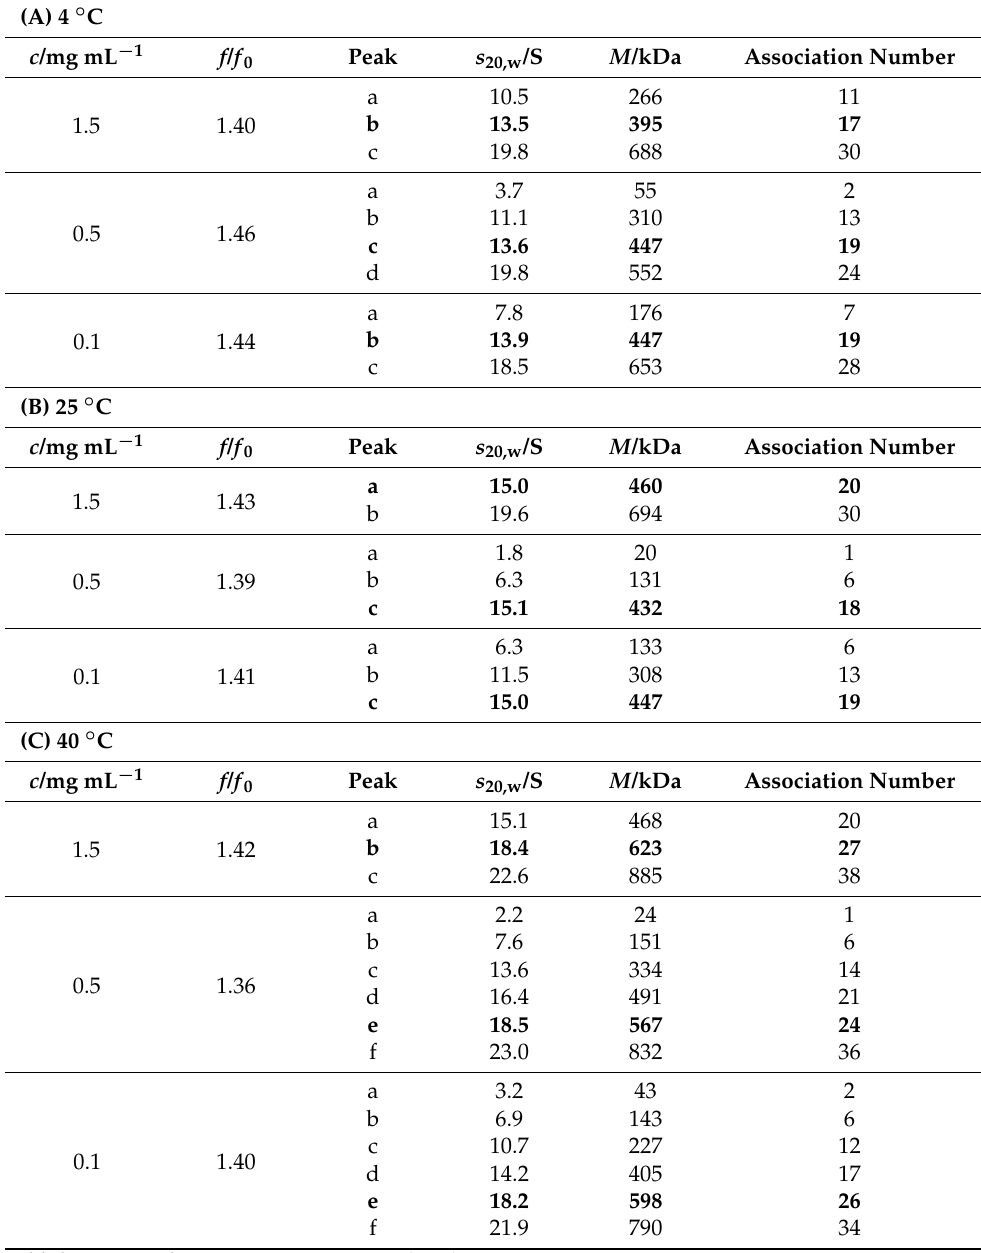
Bold characters indicate main component in c ( s 20,w